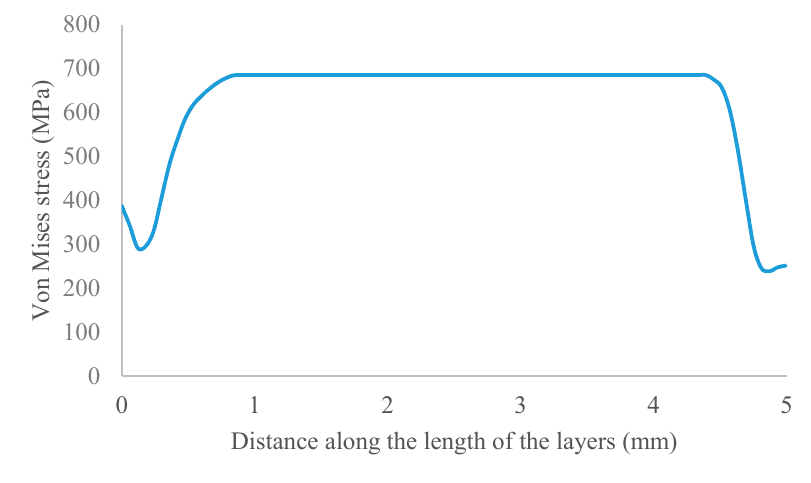
Figure 16. Von Mises stress plot ( a ) During deposition (MPa) ( b ) Zoomed-in view at the first 15 s.